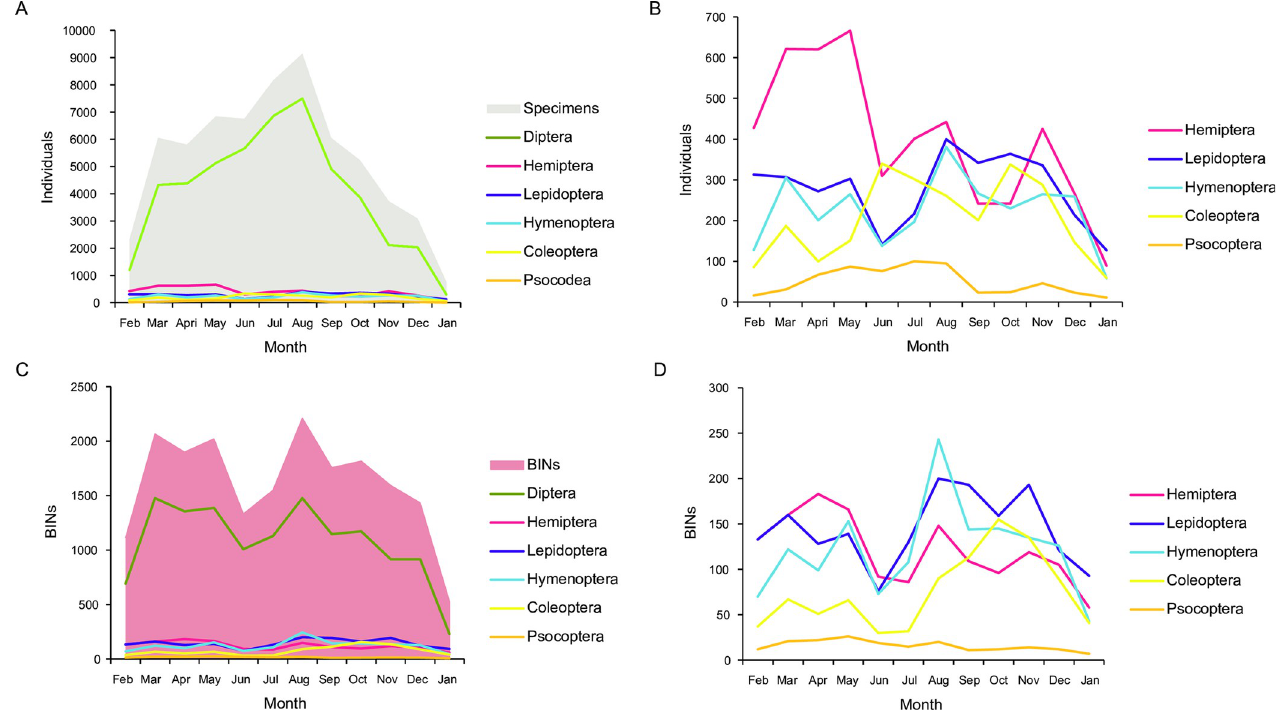
Fig 3. Abundance and richness variation in the most common orders between February 2013 and January 2014. (A) Total number of specimens and number of specimens for each of the most abundant orders throughout the year; (B) details on the number of specimens per order excluding Diptera; (C) total BINs and BINs for each of the most abundant orders throughout the year; (D) details of the BIN counts for the orders excluding Diptera.